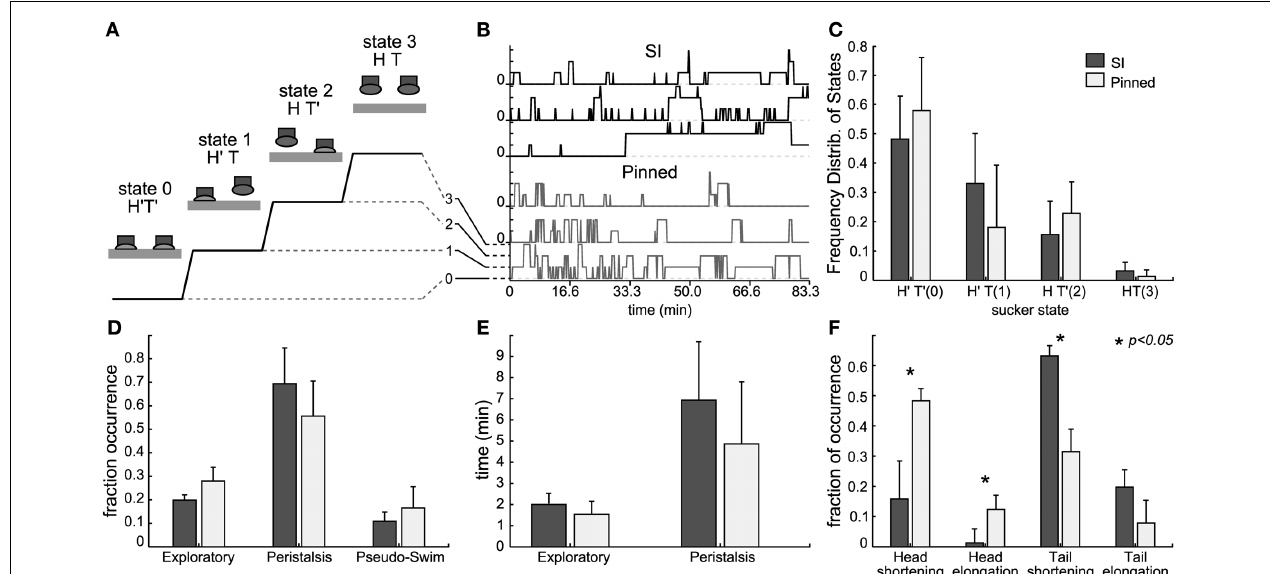
FIGURE 3 | Behaviors from head and tail sucker. (A) Diagram representing the four behavioral states of the suckers: in state 0, both suckers are attached ( H (cid:6) T (cid:6)(cid:6) ) , in state 1, the head sucker is attached while the tail sucker is detached ( H (cid:6) T ) , in state 2, the head sucker is detached while the tail sucker is attached ( HT (cid:6) ) , in state 3 the head and tail suckers are both detached (HT). (B) Example of sucker state evolution from three semi-intact experiments (top three traces in black) and three pinned experiments (bottom three traces in gray). (C) Frequency distribution of the sucker states averaged from 12 experiments. Data from semi-intact leeches in dark gray and from